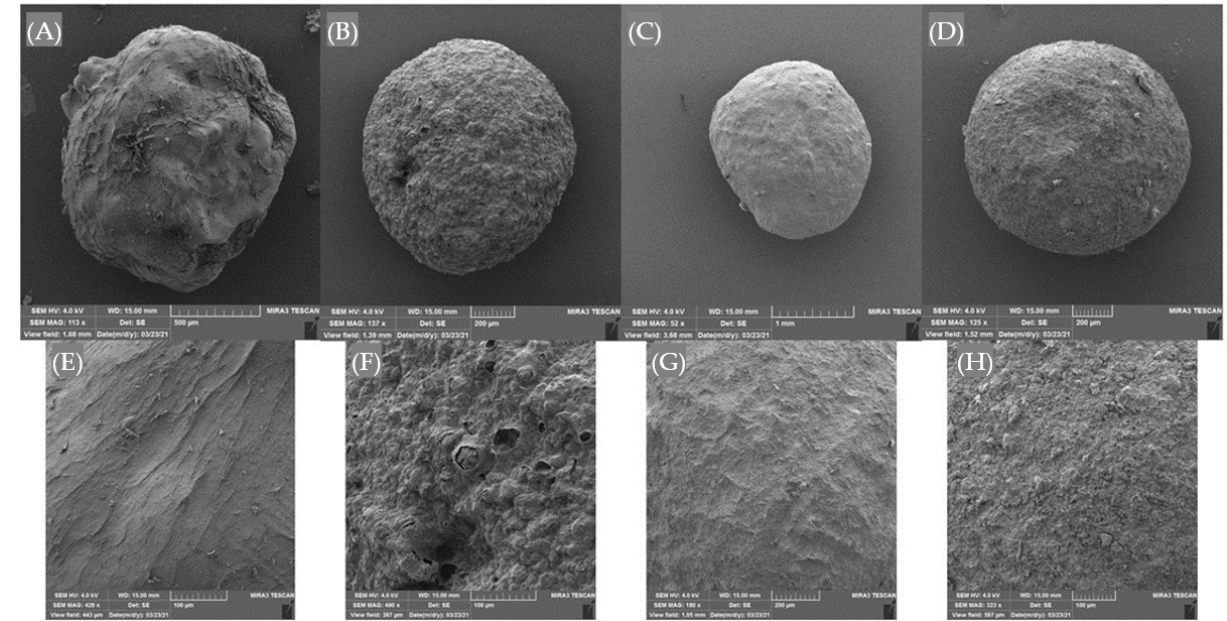
Figure 1. SEM micrographs of ( A ) alginate microparticles (As); ( B ) alginate–rice protein microparticles (A_RICs); ( C ) alginate–pumpkin protein microparticles (A_PUMs); ( D ) alginate–peanut protein microparticles (A_PEAs); surface morphology of ( E ) As; ( F ) A_RICs; ( G ) A_PUMs; ( H ) A_PEAs.